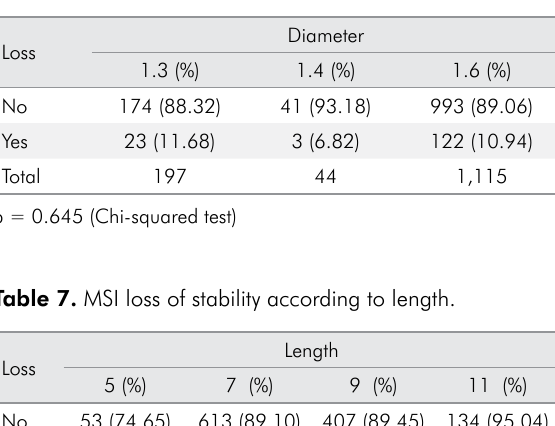
Table 6. MSI loss of stability according to diameter.